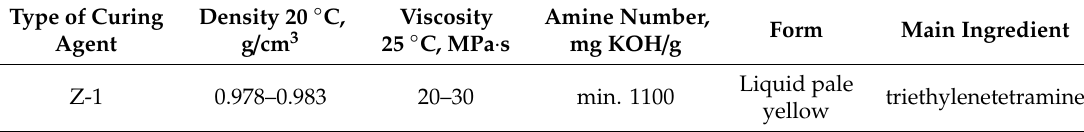
Table 2. Selected physico-chemical properties of curing agent used in the tests